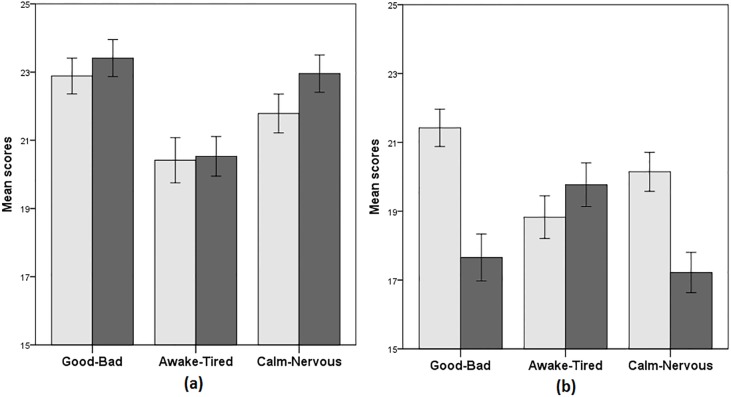
Induced stress reaction: Mood.Notes: Mood before (panel a) and after (panel b) the TSST-G procedure—scores from the Multidimensional Mood State Questionnaire. The darker color indicates the treatment group. Error bars indicate standard errors of the mean.